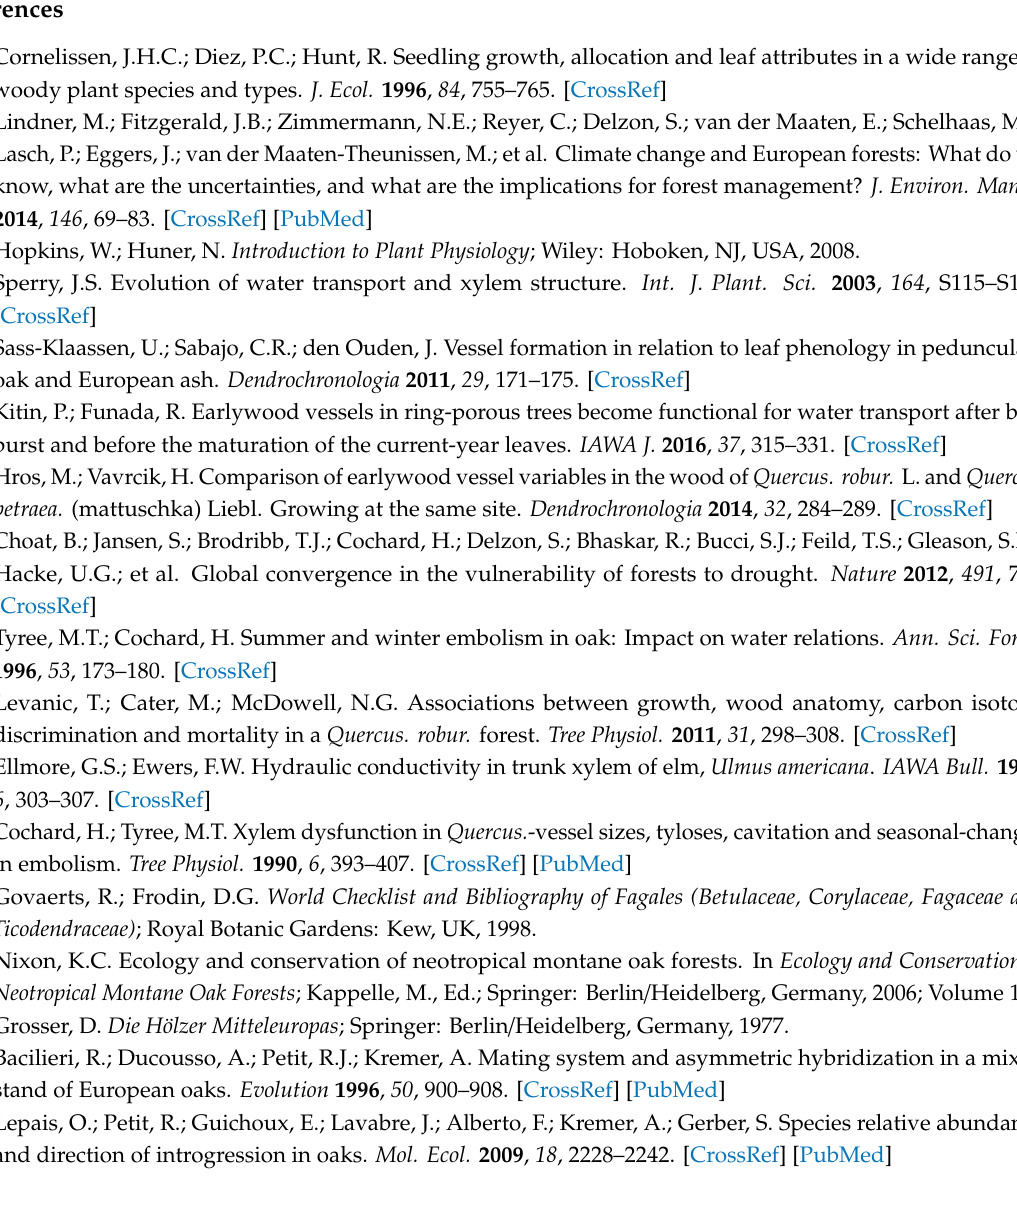
Figure S1: Height of the seedlings in both the control and the drought treated group of plants at the end of the three growing seasons, grouped according to the taxa of the mother trees. p: Q. petraea , pr: long stalked intermediate form, r: Q. robur , rp: short-stalked intermediate